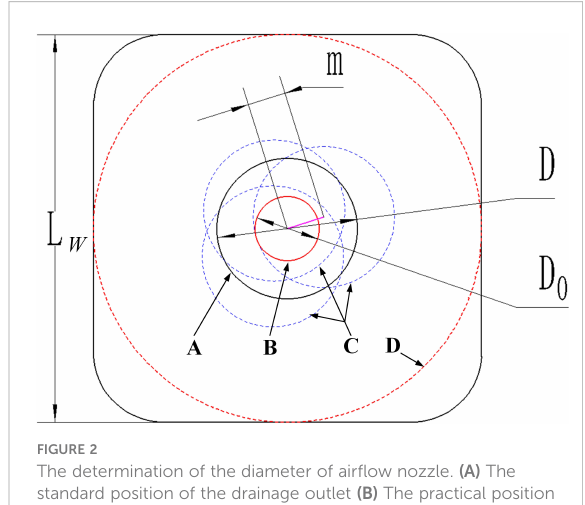
FIGURE 2 The determination of the diameter of air fl ow nozzle. (A) The standard position of the drainage outlet (B) The practical position of the eject hole (C) The possible positions of the drainage outlet (D) Inner diameter of the plug hole ’ s